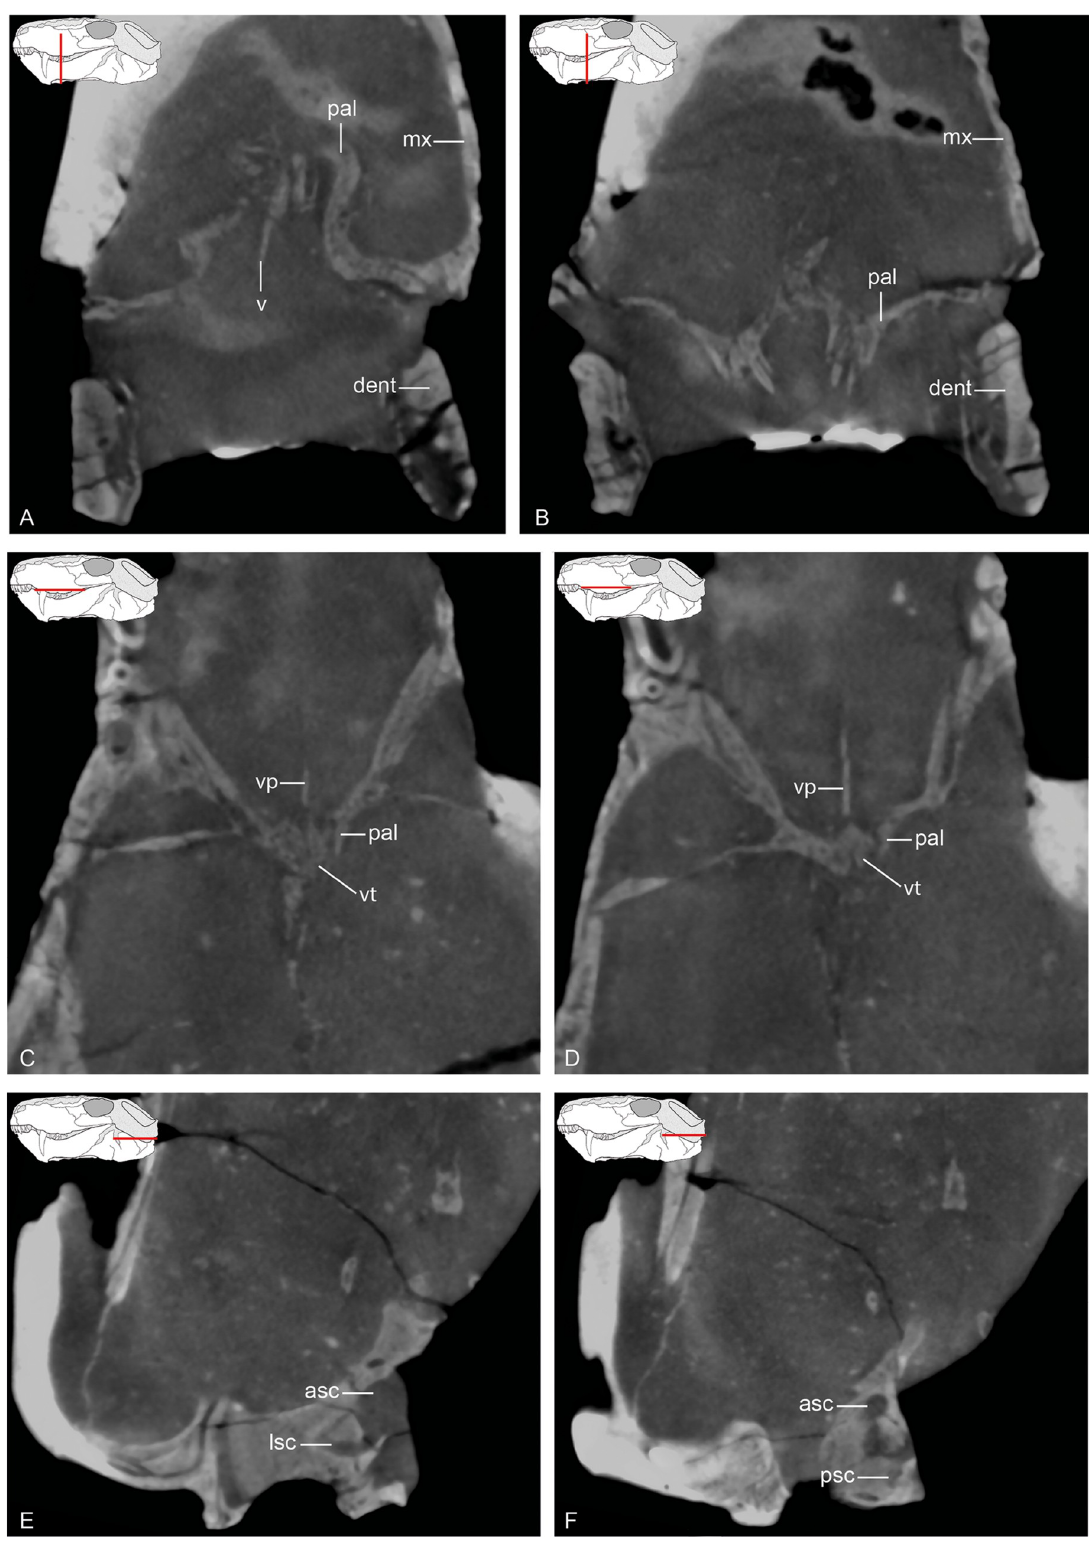
Fig 11. Tomographic slices of the neutron scan of MB.R.999. (A) and (B) coronal sections of the palatal region; (C) and (D) horizontal sections of suture of vomer and palatine; (E) and (F) horizontal sections of otic labyrinth region. Abbreviations: asc, anterior semicircular